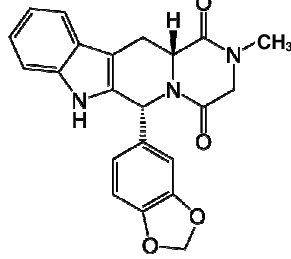
Figure 1 . Chemical structure of tadalafil.